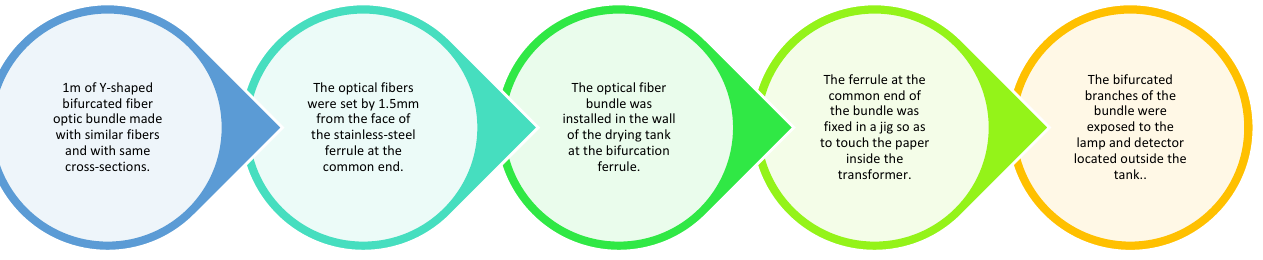
Figure 6. Summarized IR method used to directly measure WCP of the transformer (based on a study by